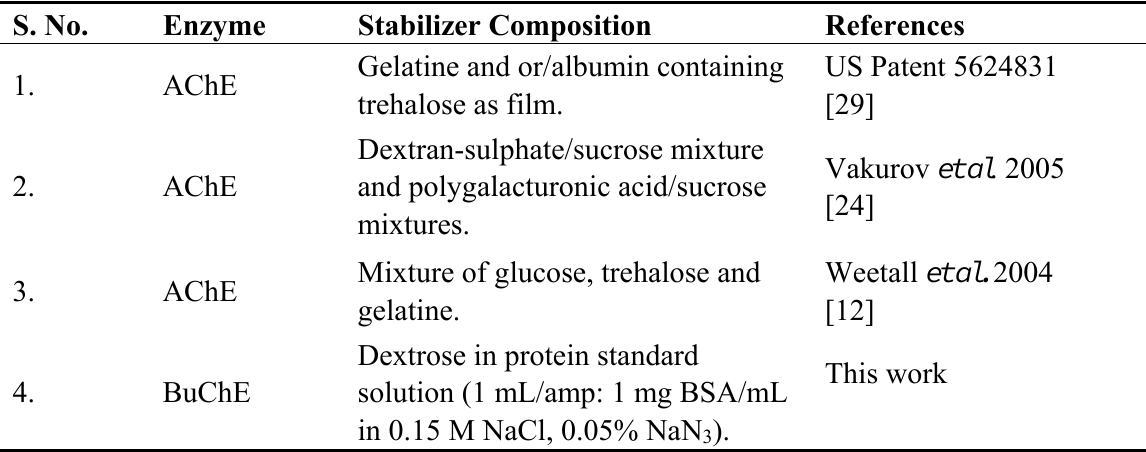
Table 1. Various stabilizer compositions reported for Cholinesterase